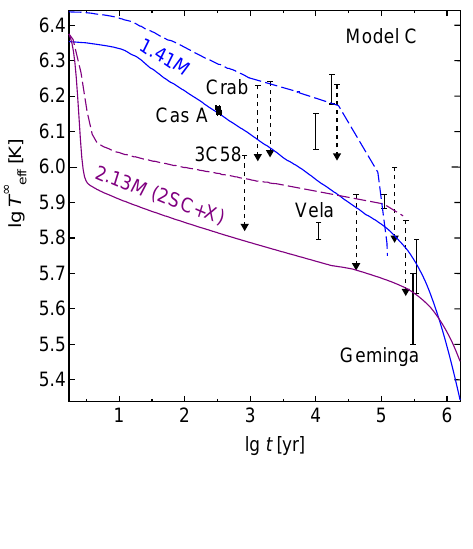
Figure 4. Cooling curves of 1.41 M ⊙ and 2.13 M ⊙ (2SC + X) with the light element surface, and with the Model C. Solid (dashed) curves denote 56 Fe ( 4 He) surface composition,